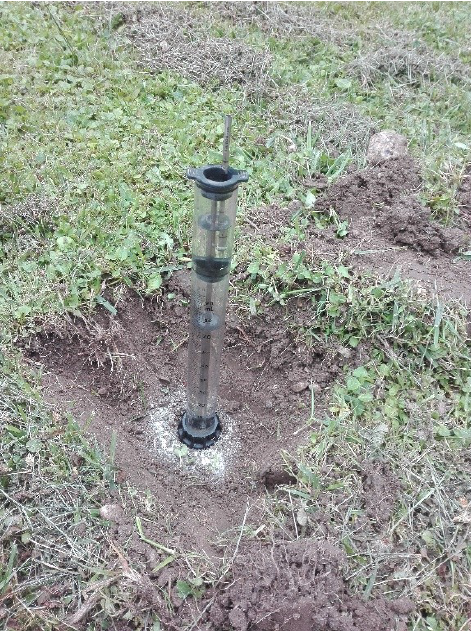
Figure 2. Mini disk infiltrometer (MDI) measurement in a pit with depth of 10 cm (D 10 ).